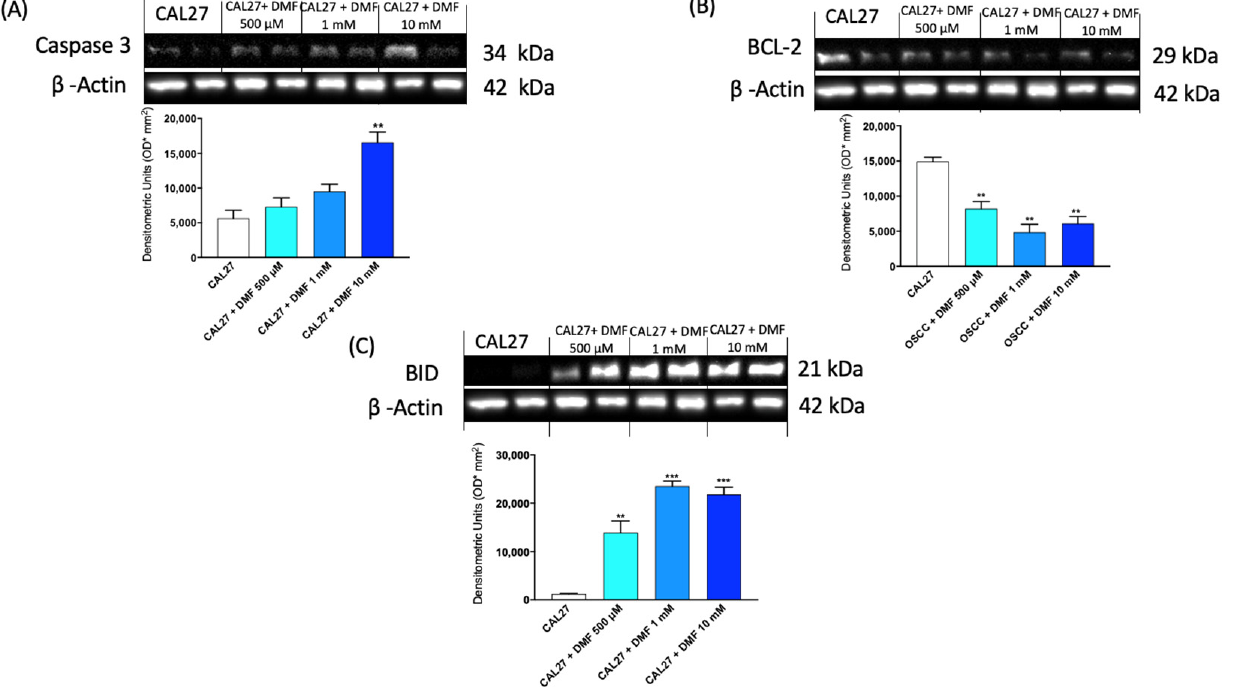
Figure 3. Effect of DMF on Caspase3, BID and BCL-2 expression in CAL27 cells ( A – C ). The blots revealed an increase of pro-apoptotic Caspase-3 and BID expression and a decrease of anti-apoptotic